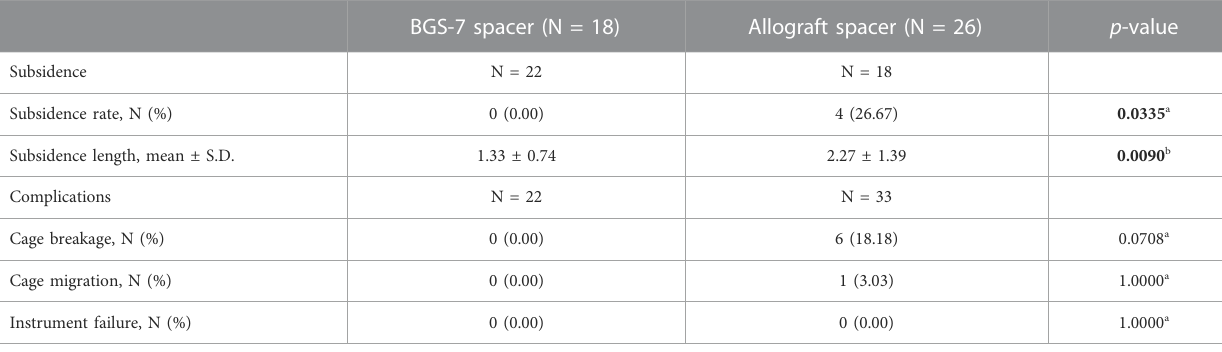
TABLE 4 Radiological outcomes (Complications).